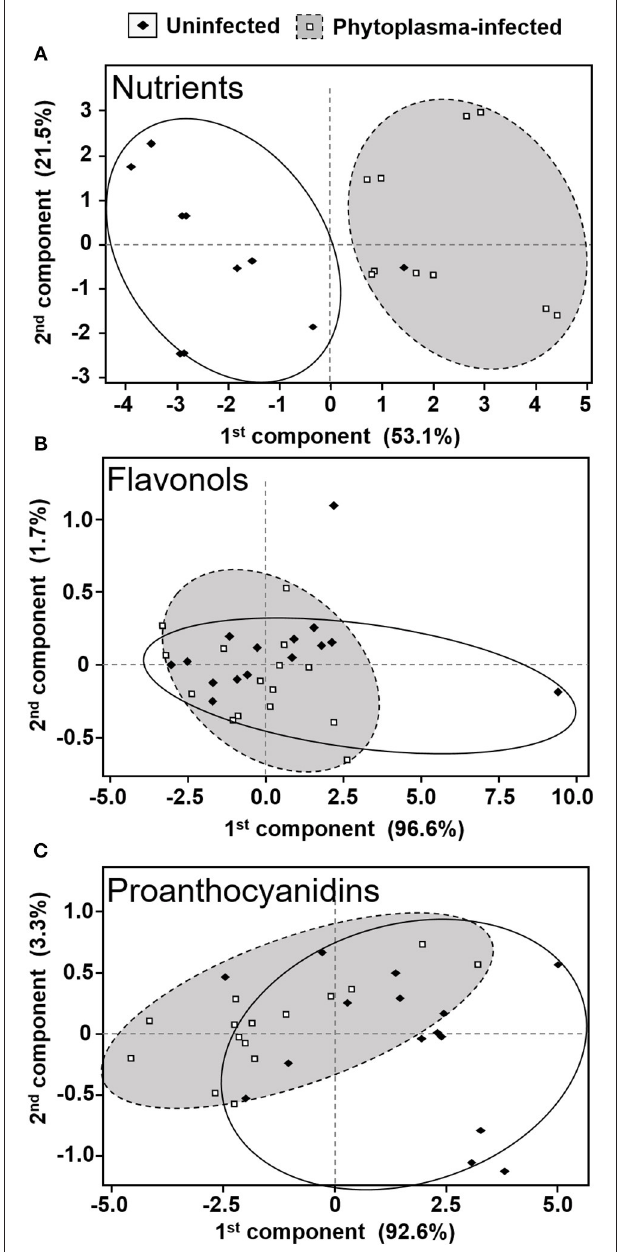
FIGURE 4 | Score plots for principal components 1 and 2 from Principal Component Analysis (PCA) for differences in nutrient (A) , flavonol (B) , and proanthocyanidin (C) composition between uninfected and phytoplasma-infected cranberry leaves. Data are grouped into clusters, each cluster enclosing 80–100% of the data for a particular group.